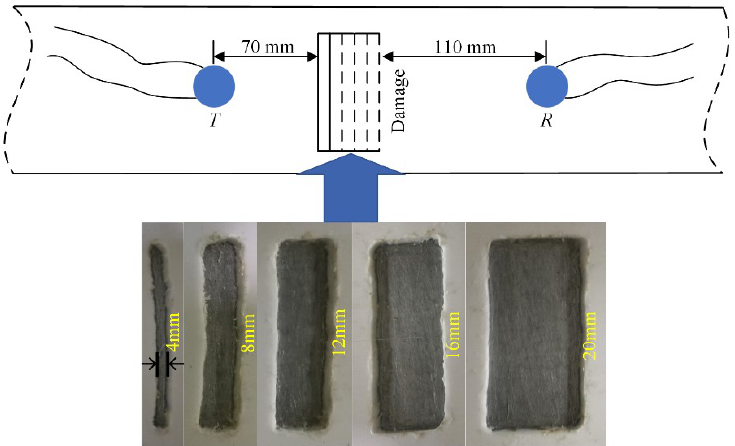
Figure 7. Schematic illustration of delamination damage. T and R stands for excitation transducer and receiving transducer respectively.